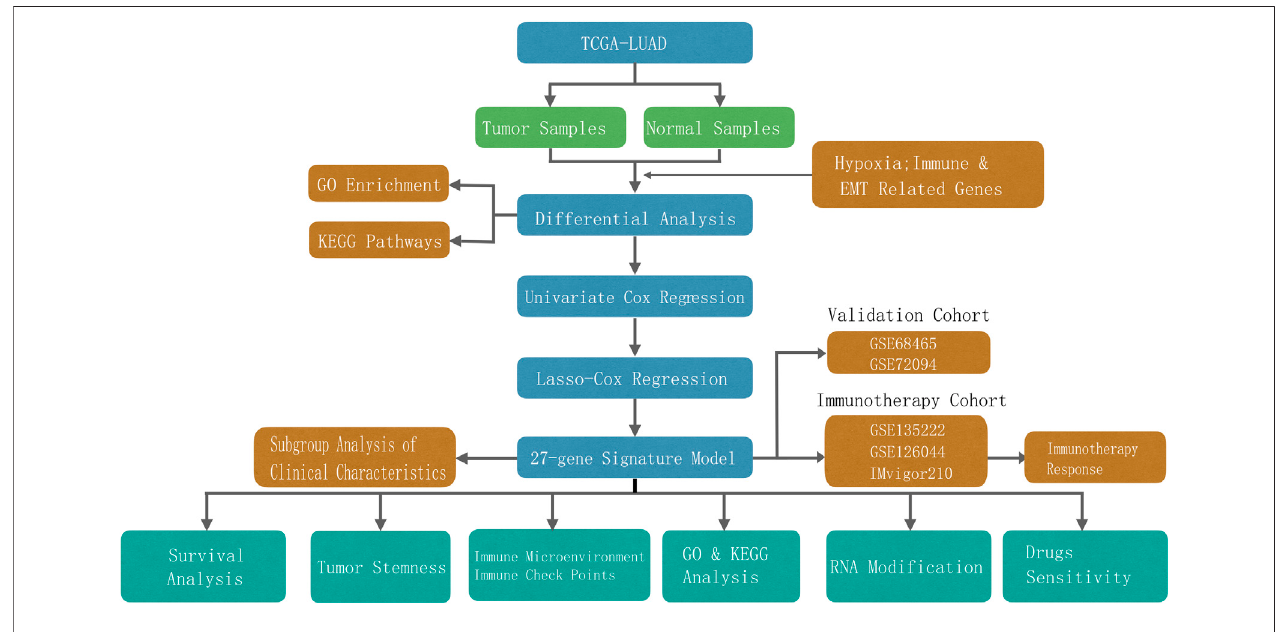
FIGURE 1 | Flow chart of this